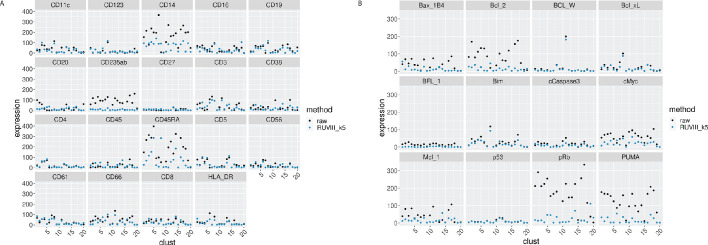
EMD for all the proteins by cluster, before and after CytofRUV normalisation of the CLL2 sample, k = 5.(A) EMD for lineage proteins by cluster before (black) and after (blue) CytofRUV normalisation (blue). (B) Same as (A), with functional proteins.